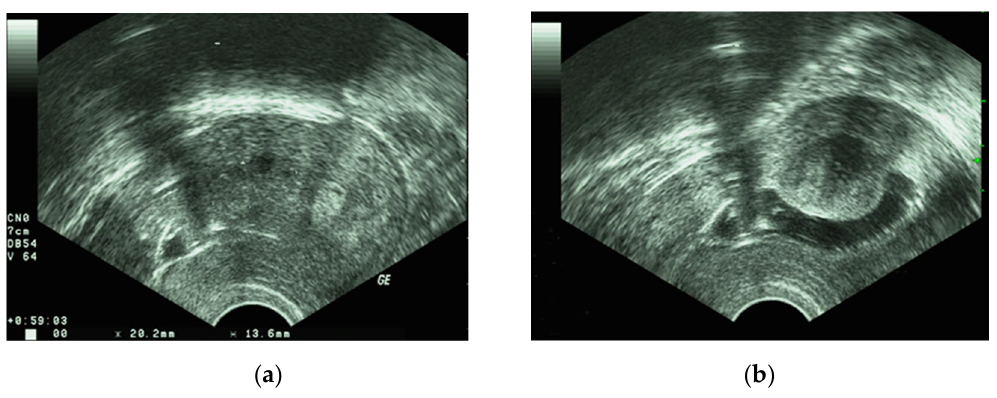
Figure 3. ( a ) fibroid on 2D ultrasound; ( b ) fibroid on hysterosonography. A “normal” 2D transvaginal ultrasound may be supplemented with a 3D transvaginal ultrasound. The latter permits reconstruction of the coronal plane of the uterus and thus demonstrates the exact location of the fibroid and distortion of the cavity due to submucosal fibroids [47,48]. Figure 4a,b show a myoma on 2D and 3D vaginal ultrasound.